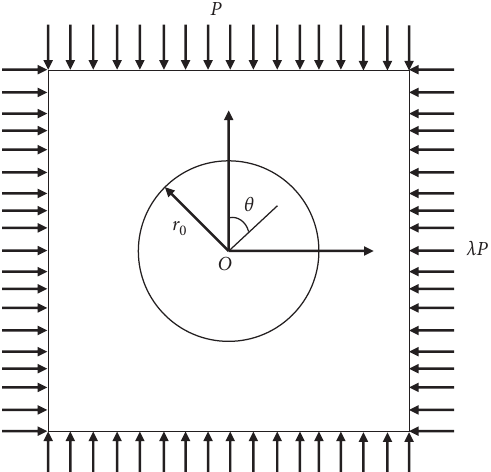
Figure 9: Stress calculation model of surrounding rock of circular